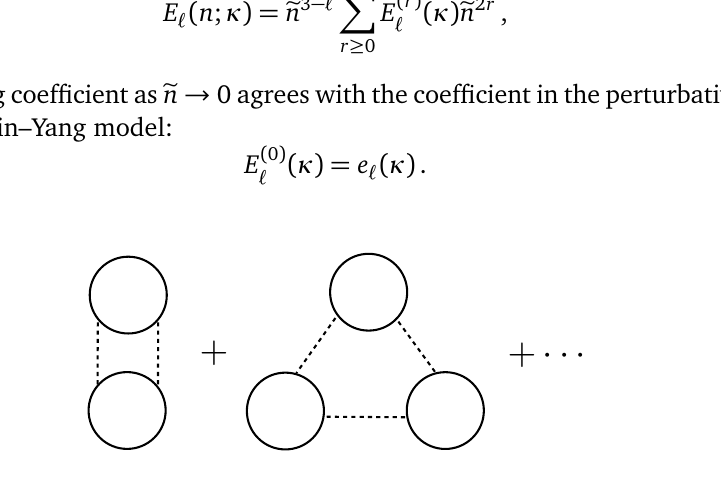
Figure 1: Ring diagrams with (cid:96) ≥ 2 bubbles. The fermions are represented by full lines. The interaction four-vertex of (6) is represented as a dashed